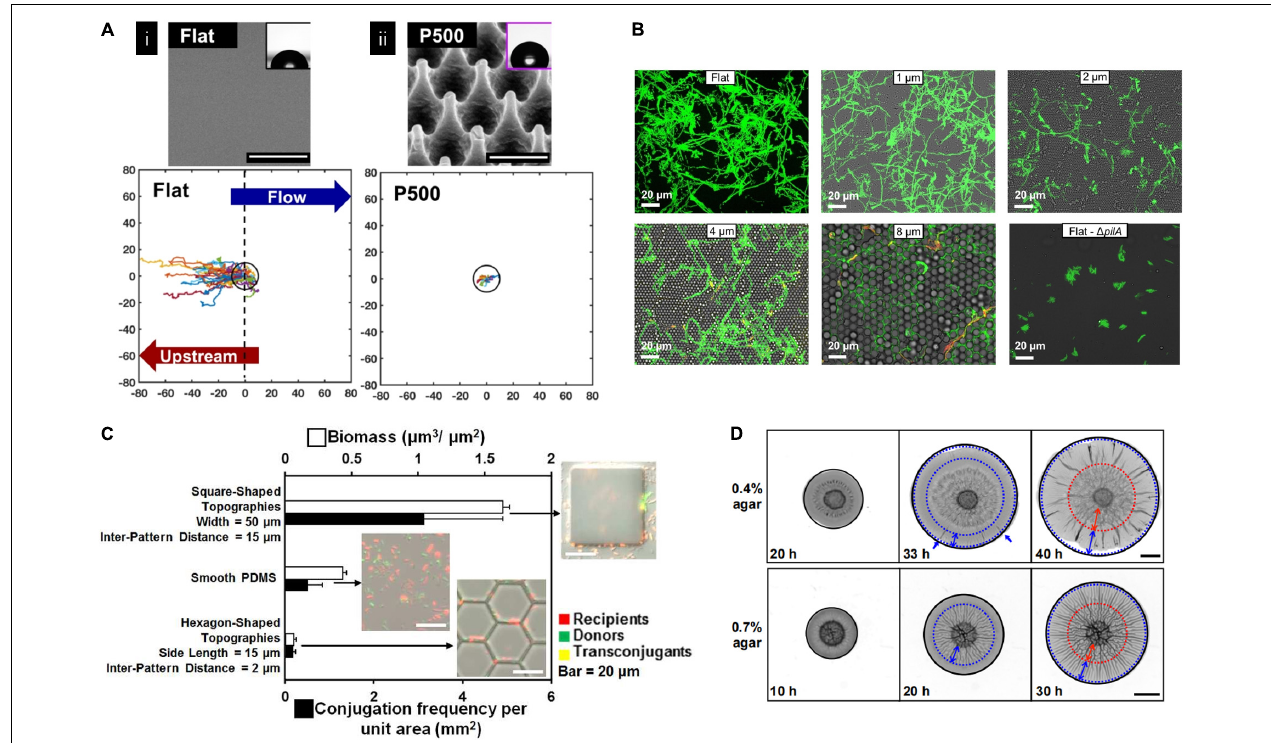
FIGURE 3 | (A) Nanopillared topography inhibited bacteria upstream motility indicated by single-cell trajectories. Single-cell trajectories of Pseudomonas naeruginosa on the flat surfaces originated from 0 and extended to the –80 µ m in x -direction indicating upstream motility, while much less motility distance was observed on a nanopillar topography (P500). The black ring is 10 µ m radium as a reference (Rosenzweig et al., 2019). Adapted with permission from Rosenzweig et al. (2019). Copyright 2019 American Chemical Society. (B) Hemisphere topography affected bacterial migration. Fluorescence images showing P. aeruginosa movement traces. It showed bacteria appear to explore a smaller fraction of the flat surface compared with hemisphere topography surfaces with 2–8 µ m features (Yow-Ren Chang and Ducker, 2018). Adapted with permission from Yow-Ren Chang and Ducker (2018). Copyright 2018 American Chemical Society. (C) Conjugation frequency and biofilm formation of Escherichia coli were influenced by surface topography. The square-shaped pattern showed higher conjugation frequency than smooth and hexagon-shaped surfaces (Gu et al., 2017). Adapted with permission from Gu et al. (2017). Copyright 2017 American Chemical Society. (D) Representative images of Vibrio cholerae biofilm grown on different substrates at different time points. Blue dotted circles mark the boundaries of regions with radical patterns, and red dotted circles mark the boundaries of regions with zigzag patterns. It showed biofilm morphology differed on different substrate’